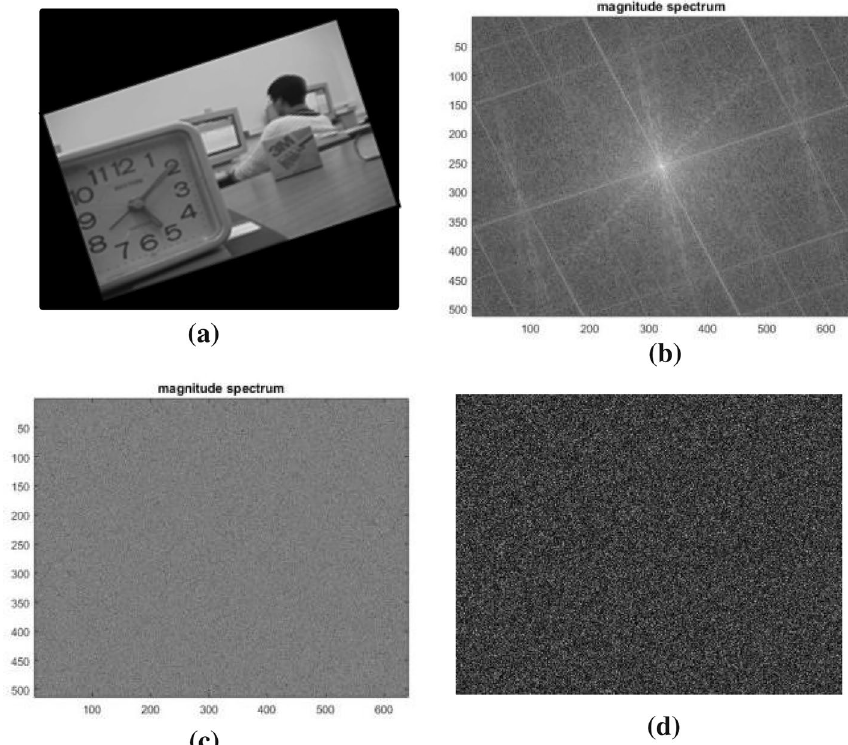
Fig. 8 A The rotational attack of original I‑frame, b The magnitude spectrum of original I‑frame. C The magnitude spectrum of encrypted rotational I‑frame d Encrypted the rotational I‑frame original I‑frame